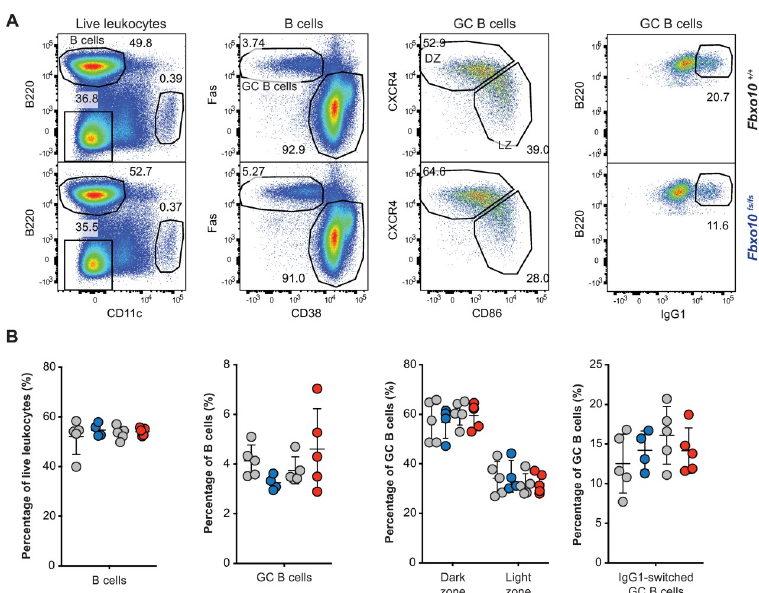
Fig 3. Fbxo10 frameshift or missense mutation do not visibly expand or alter the GC response to SRBC immunisation. (A) Representative flow cytometric gating strategy to delineate GC B cells responding to SRBC immunisation. Numbers denote cells in the gate as a percentage of parent population. (B) Frequency of B cells, GC B cells, light zone/dark zone distribution and IgG1-class-switched GC B cells in the spleen of Fbxo10 +/+ (grey circles matched with mutant siblings) Fbxo10 fs/fs (blue circles), and Fbxo10 E54K/E54K (red circles) mice day 7 post- immunisation. B: each dot represents an individual biological replicate. Data are representative of n = 2 experiments on mice 10–20 weeks old. Statistical analysis: t-test corrected for multiple comparisons using the Holm-Sidak method yielded no evidence for significant differences between mutants and wildtype controls with p < 0.05.